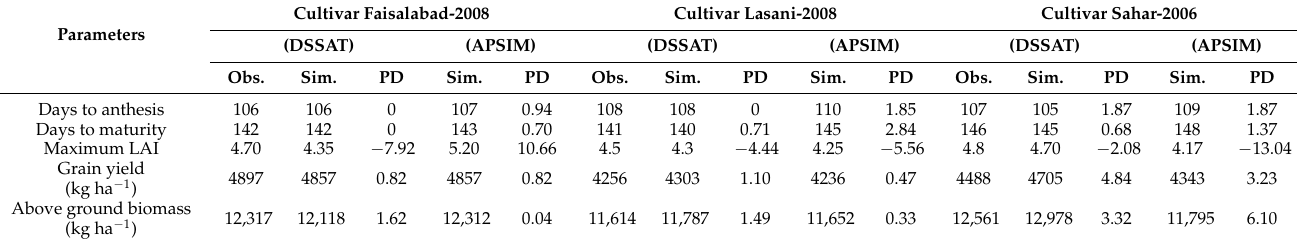
Table 3. Comparison of observed and simulated anthesis, maturity days, leaf area index, grain yield and biological yield of cultivars Faisalabad 2008, Lasani-2008 and Sahar-2006 for the parameterization of DSSAT (CERES-Wheat) and APSIM (APSIM-Wheat) during 2008–2009.